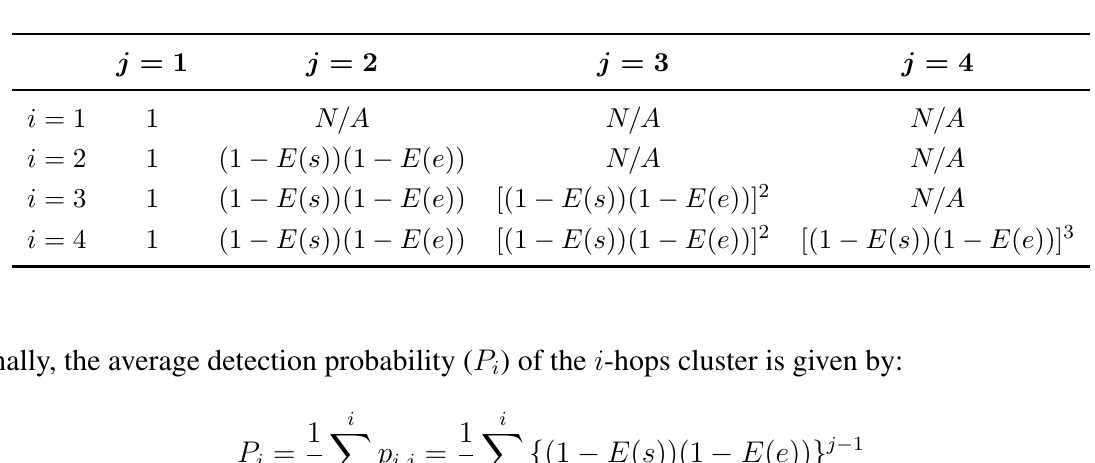
Table 2. Detection probability ( p